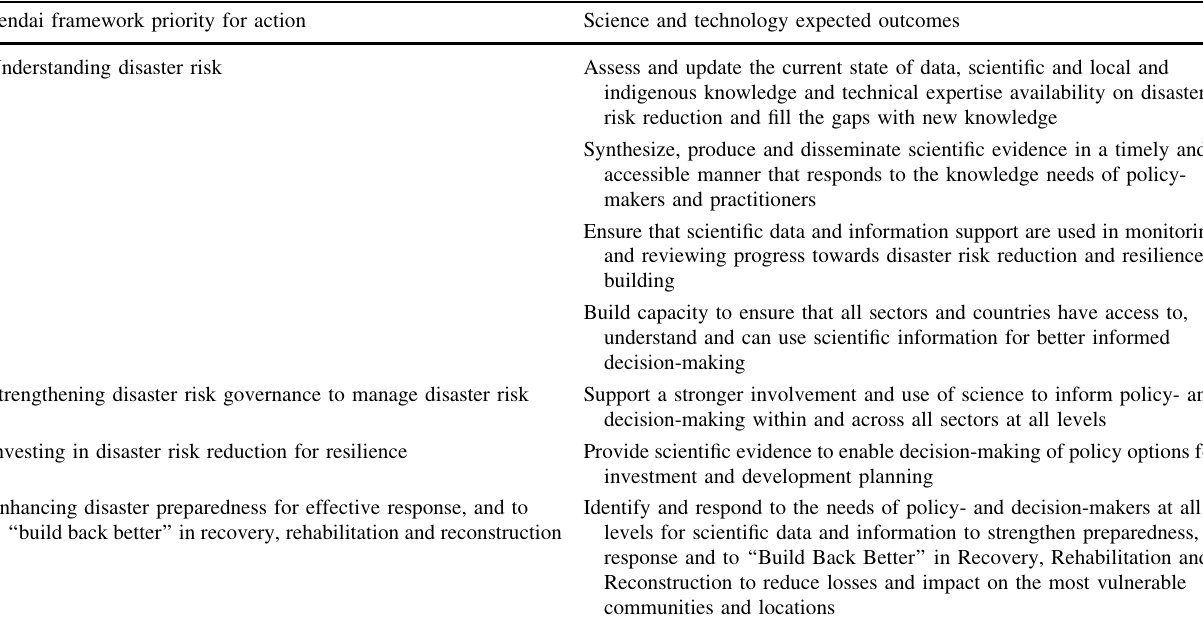
Table 1 Summary of the expected outcomes of the Science and Technology Road Map to support the implementation of the Sendai Framework. Source UNISDR (2016a, p. 3) Sendai framework priority for action Science and technology expected outcomes Understanding disaster